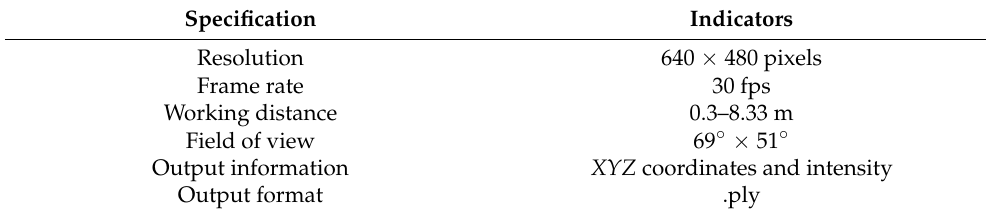
Table 3. Helios2 depth camera specifications.